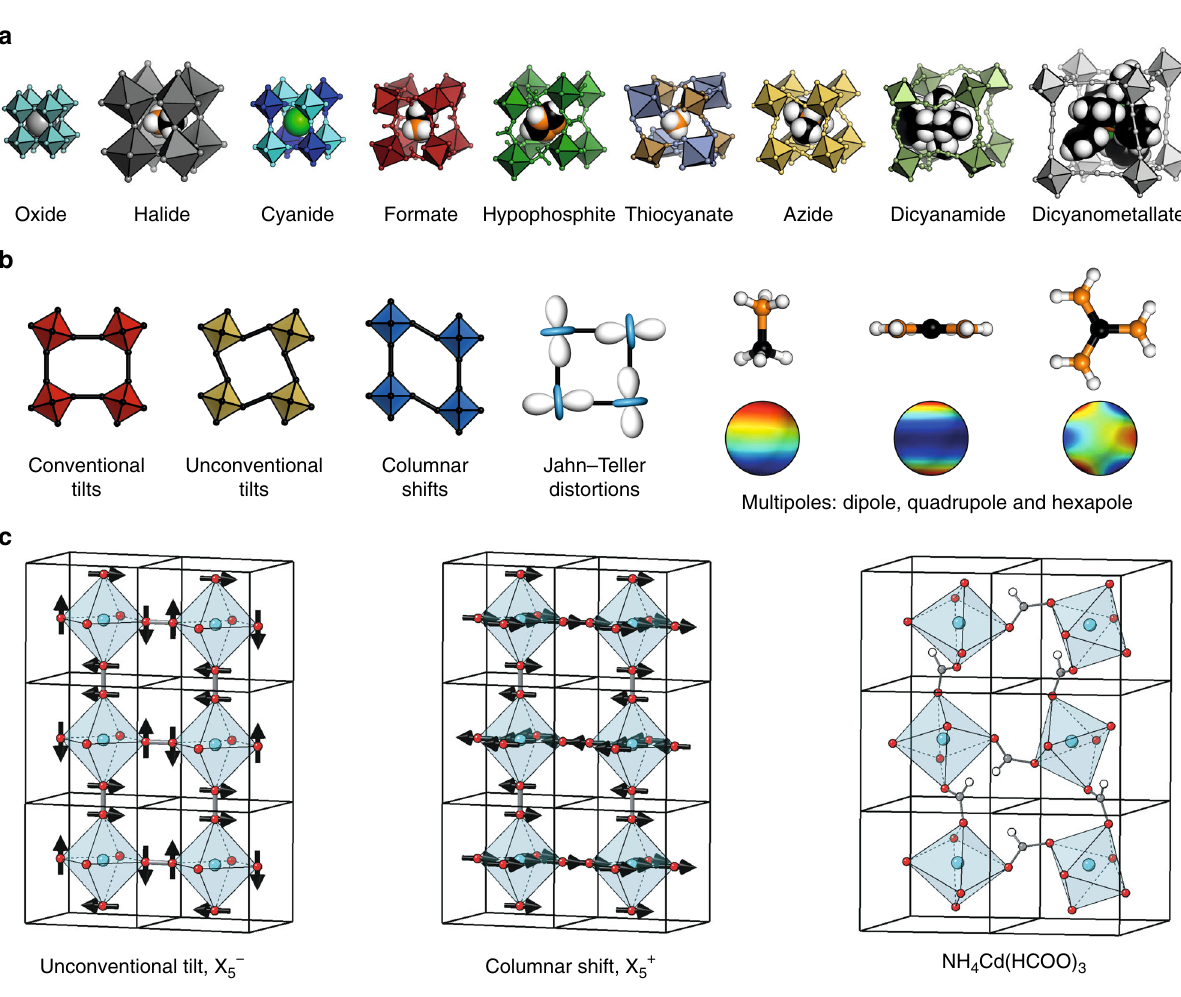
Fig. 1 Molecular perovskites and their degrees of freedom. a A perovskite oxide with the molecular congeners shown to scale. In all cases, the A-site cation is shown as space fi lling, with carbon in black, hydrogen in white, nitrogen in orange, and phosphorus in green. b Schematic illustrations of the various degrees of freedom accessible to molecular perovskites. c A combination of two such distortions — an unconventional tilt (left) and columnar shift (centre) — is responsible for the crystal symmetry of [NH 4 ]Cd(HCOO) 3 (right). Note that the unconventional tilt results in some neighbouring coordination octahedra rotating in the same sense, which is possible only because the X-site anions are molecular